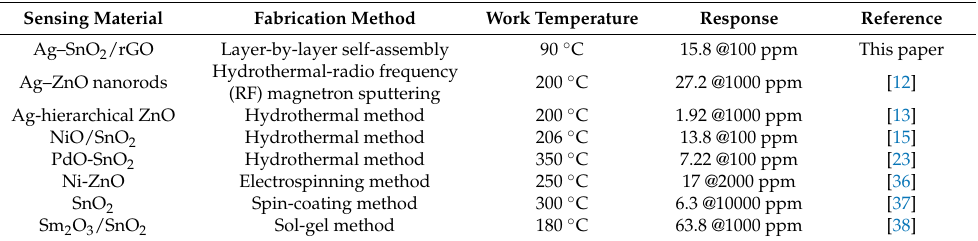
Table 1. Performance of the presented sensor in this work compared with previous works.